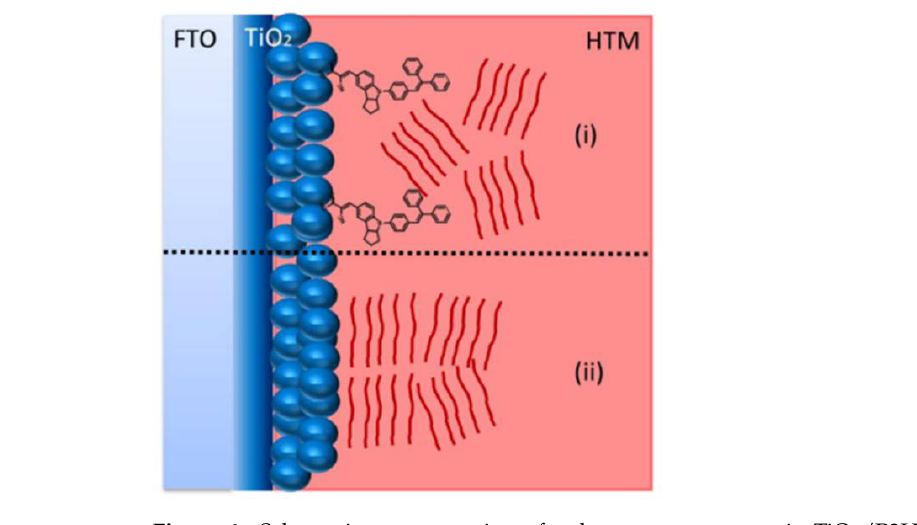
Figure 6. Schematic representation of polymer arrangement in TiO 2 /P3HT HSCs when ( i ) the interface is modified with small molecule sensitizers and ( ii ) unmodified interface. Table 4. Small molecule sensitizers as interfacial modifiers in hybrid Titanium dioxide/Poly(3- hexylthiophene) heterojunction solar cells.